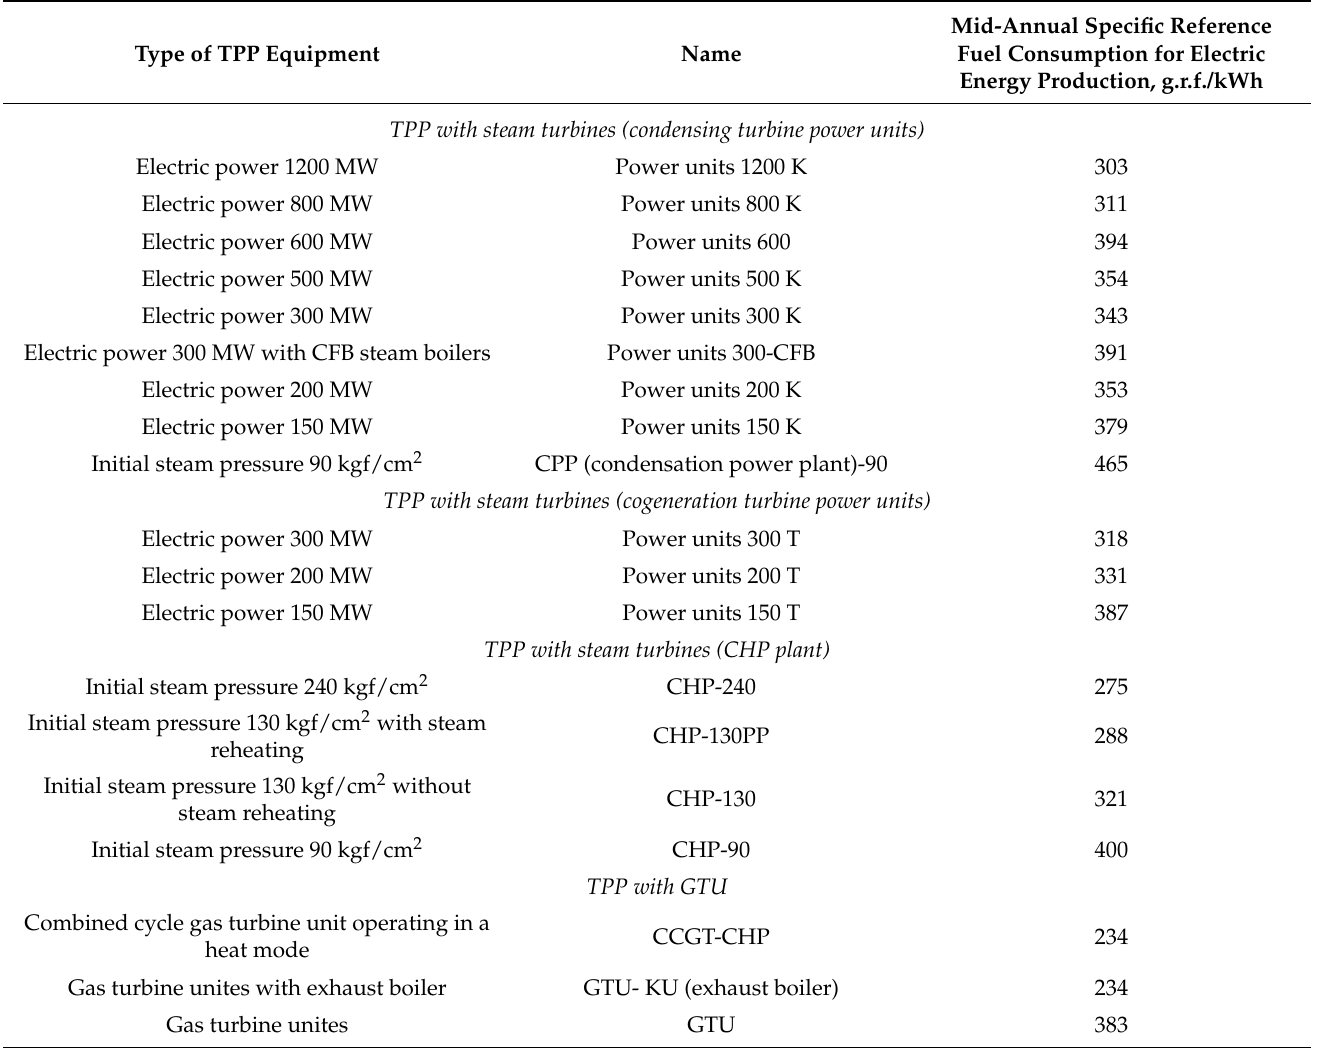
Table 2. Specific reference fuel consumption for electric energy production for the most common types of TPP equipment in the Russian Federation (Source: Thermal Power Engineering and District Heating of Russia in 2014–2018 (information and analytical